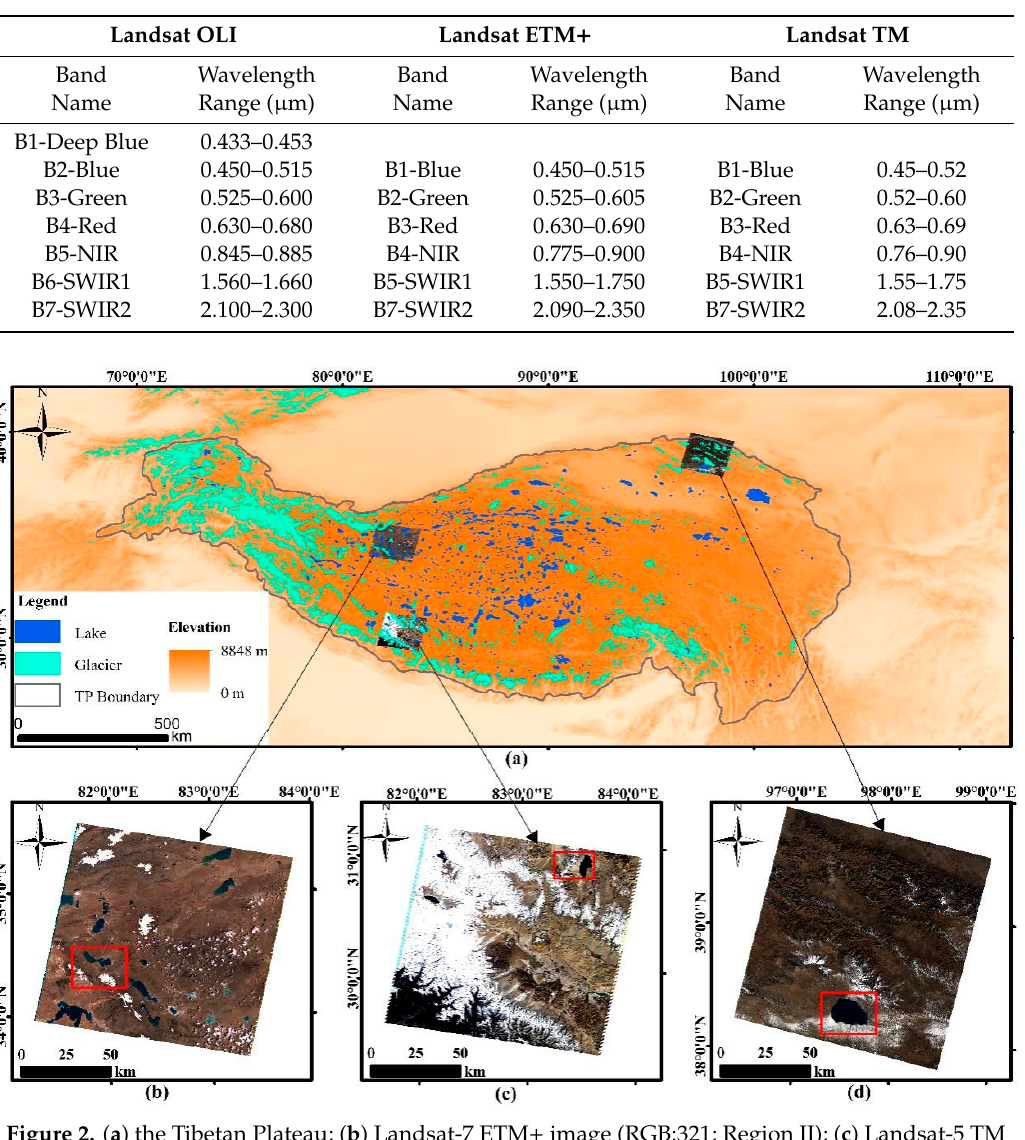
Table 1. Basic characteristics of Landsat Operational Land Imager (OLI), Enhanced Thematic Mapper Plus (ETM+) and Thematic Mapper (TM) data.